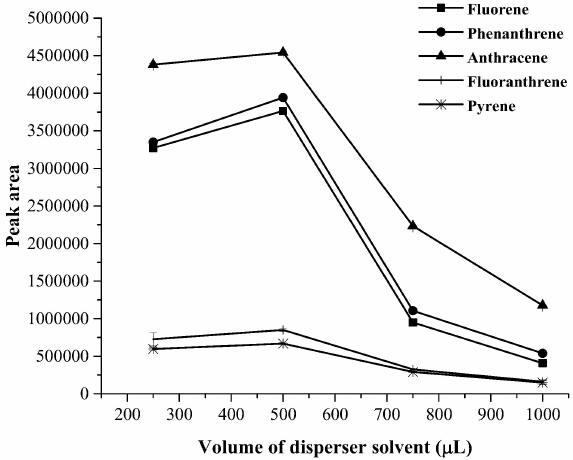
Figure 4. Effect of volume of disperser solvent on the extraction